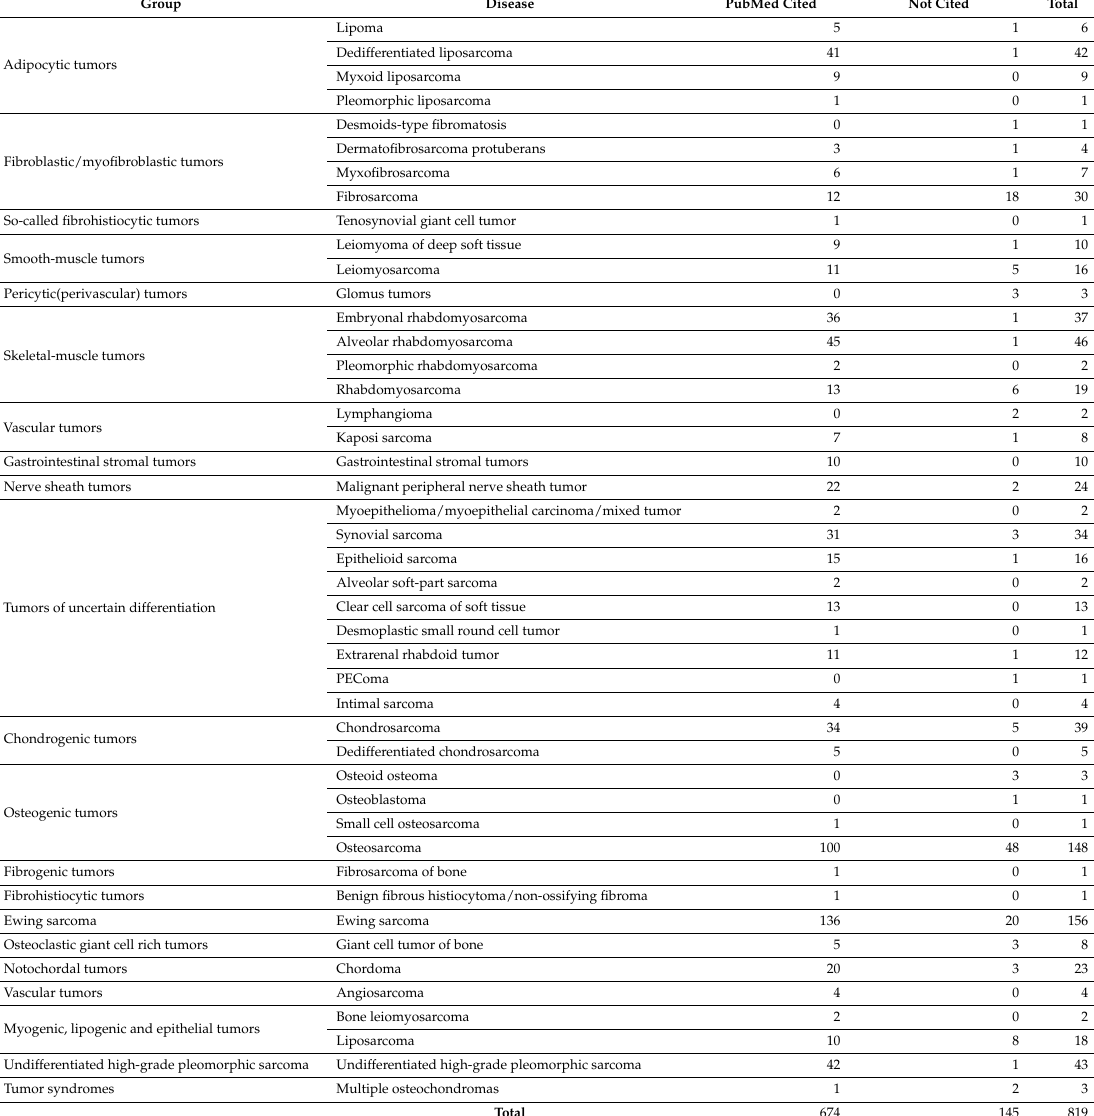
Table 4. PubMed citation of WHO classified original cell